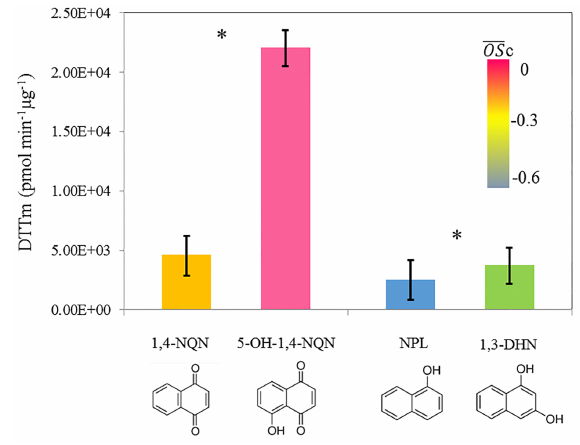
Figure 6. DTT m for two selected pairs of oxygenated derivatives in NSOA system (1,4-NQN vs. 5-OH 1,4-NQN and NPL vs. 1,3- DHN). Averaged carbon oxidation state (OSc) of each component is shown in color (color scale shown on top right). Each measure- ment was conducted in triplicates, and the error bar here represents the SEM. The asterisk indicates significant difference between each pair of measurements at the 95% confidence